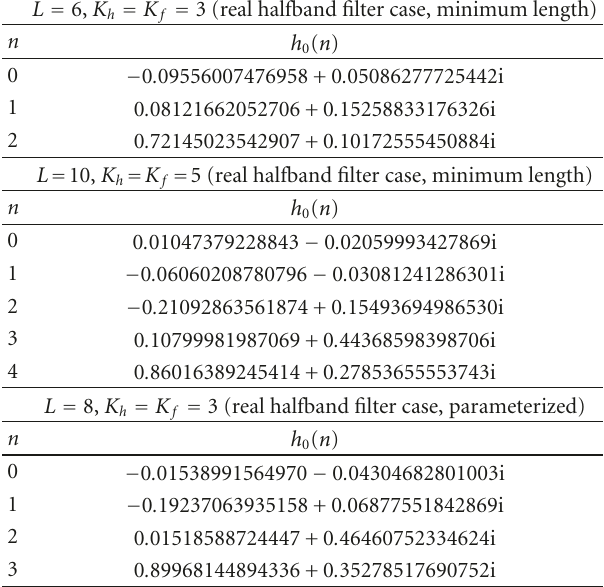
Table 1: Filter coe ffi cients of conjugate symmetric two-band complex biorthogonal filterbank.